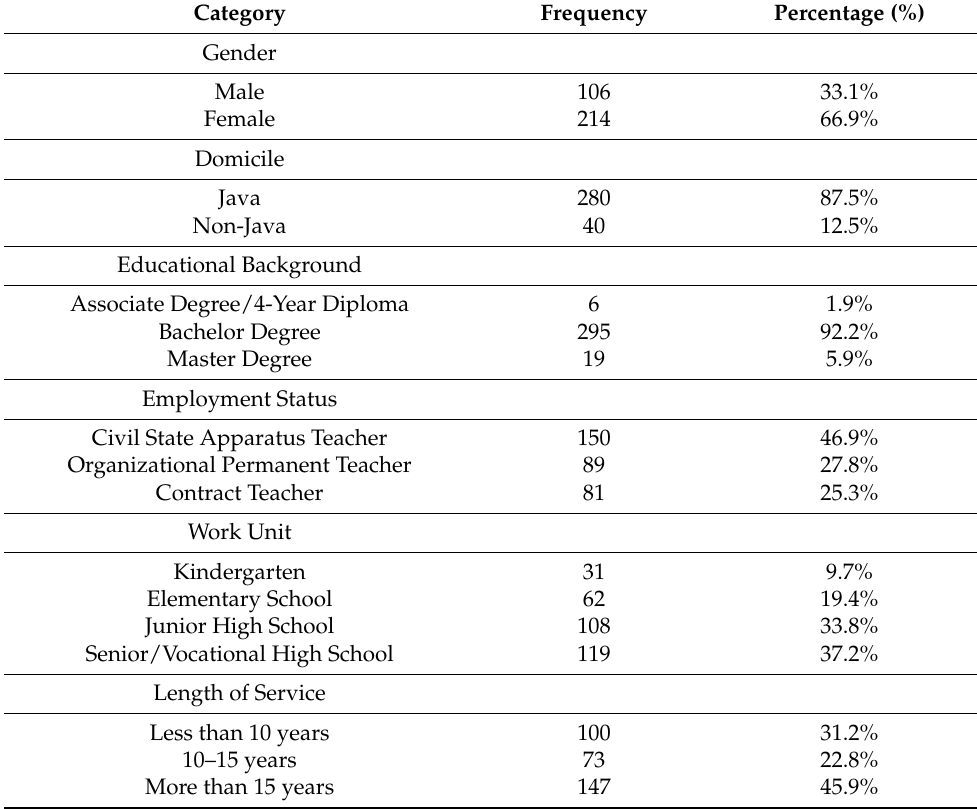
Table 1. Participants’